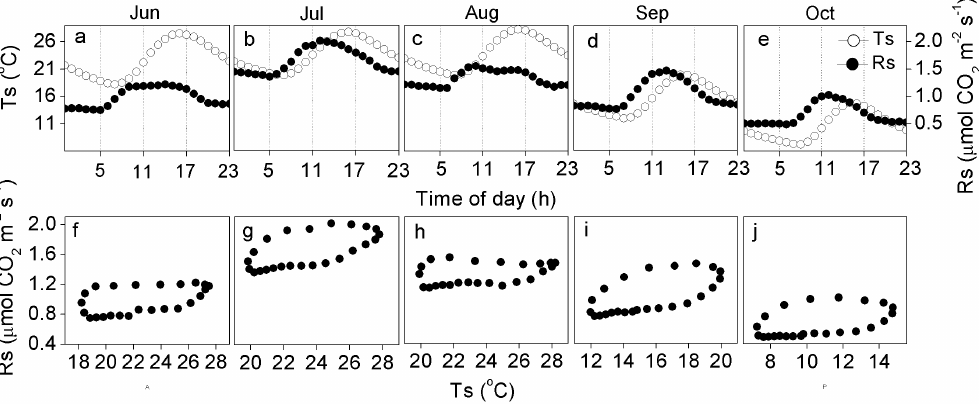
Fig. 1. Mean monthly diel cycles of soil respiration (Rs) and soil temperature (Ts). Each point is the monthly mean for a particular time of day.